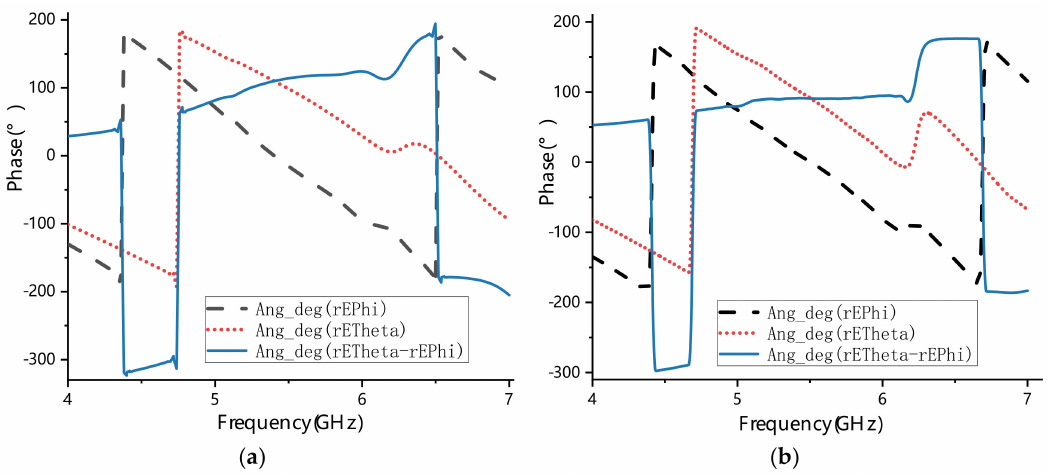
Figure 5. Phases of E 1 , E 2 , and their di ff erences in ( a ) the metasurface with four parasitic square cross gaps and ( b ) the metasurface with seven parasitic square cross